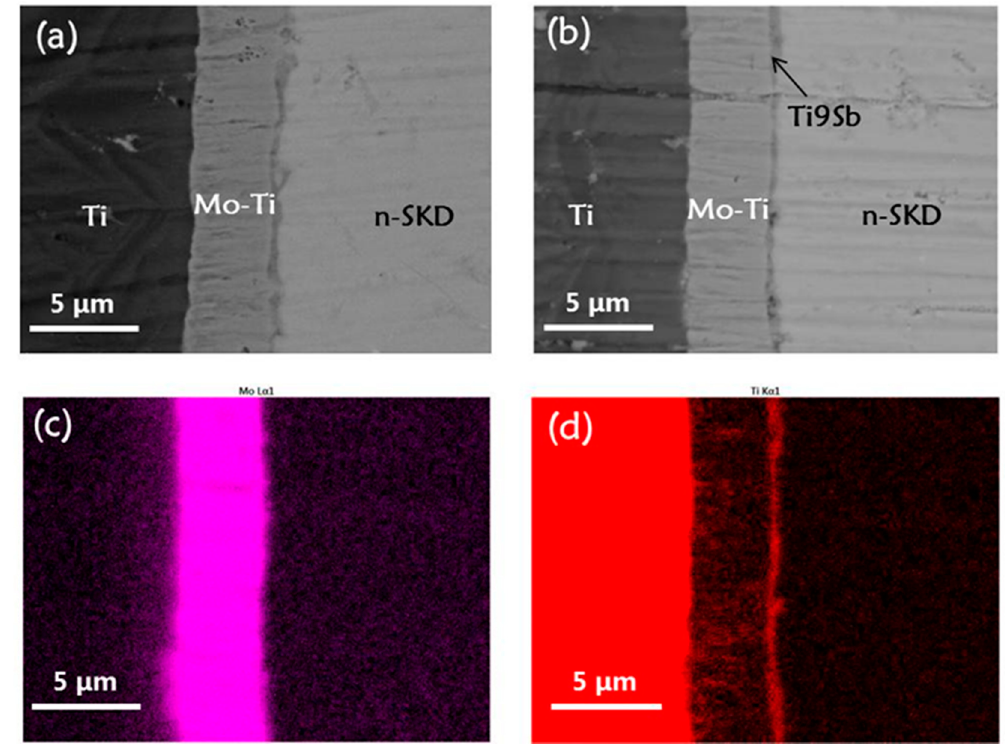
Figure 4. The interfacial evolution of the pretreated joints isothermally aged at 550 °C. ( a ) BSE graph, 20 days; ( b ) BSE graph, 50 days; ( c ) distribution of Mo, 50 days; ( d ) distribution of Ti, 50 days.